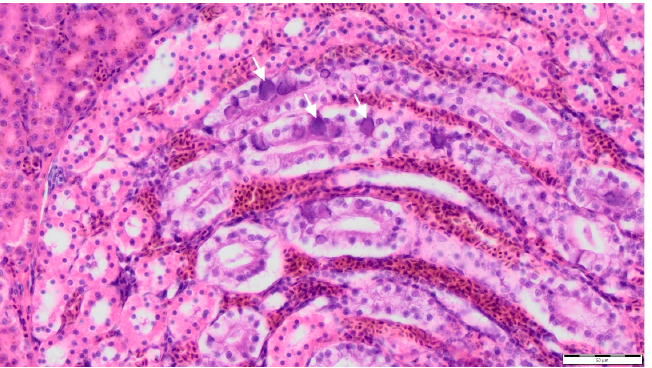
Figure 4. Micrograph of a kidney from a red-crowned parakeet ( Cyanoramphus novaezelandiae ) labelled as case no. 1 with large eosinophilic intranuclear inclusion bodies (white arrows) in the epithelial cells of the collecting ducts. Haematoxylin and eosin staining, 400x magnification.